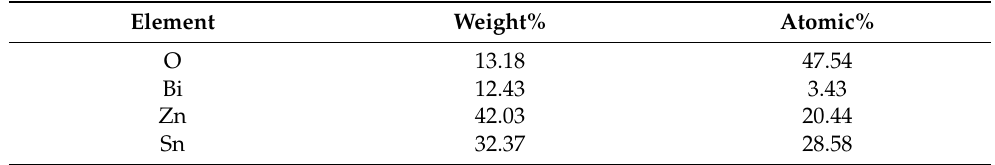
Table 1. Elemental mass ratio and atomic percentage of Bi-ZnSnO 3 (4 wt%).